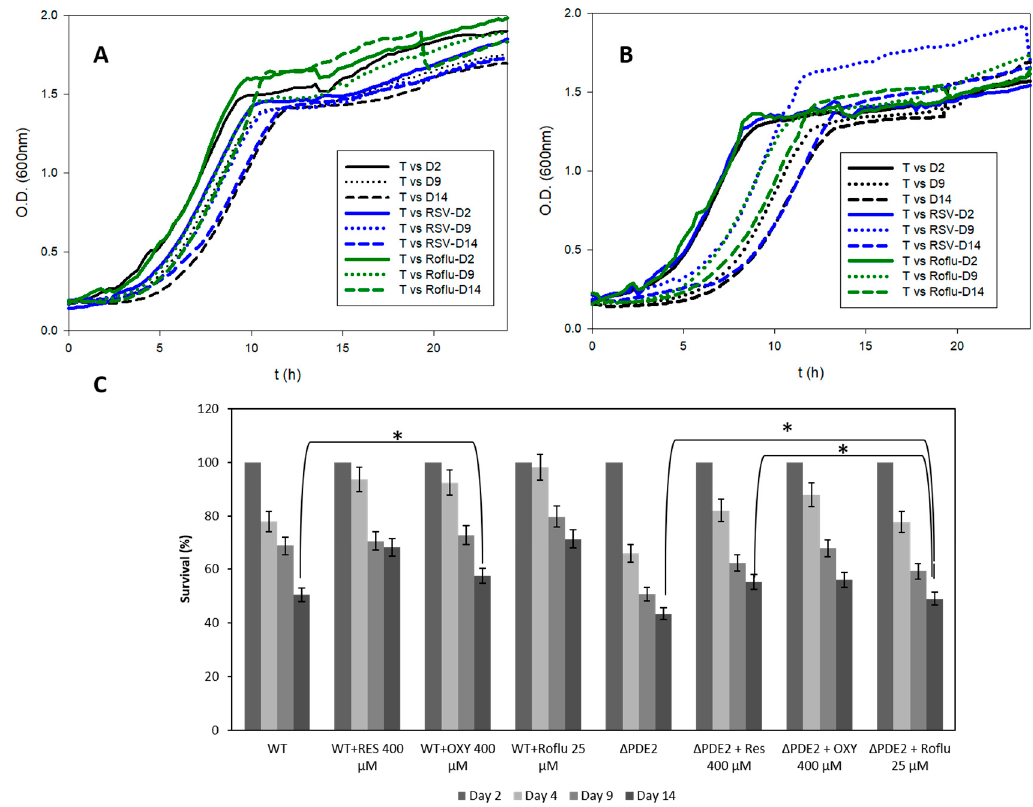
Figure 5. Optical density of maintained cultures at different times (Day 2, 9 and 14) for ( A ) WT and ( B ) ∆ PDE2 with or without 400- µ M RSV or 25- µ M roflumilast; ( C ) Comparative analysis of the survival in all treated cultures. (* means p < 0.05 in most relevant results, errors bars represent SD).